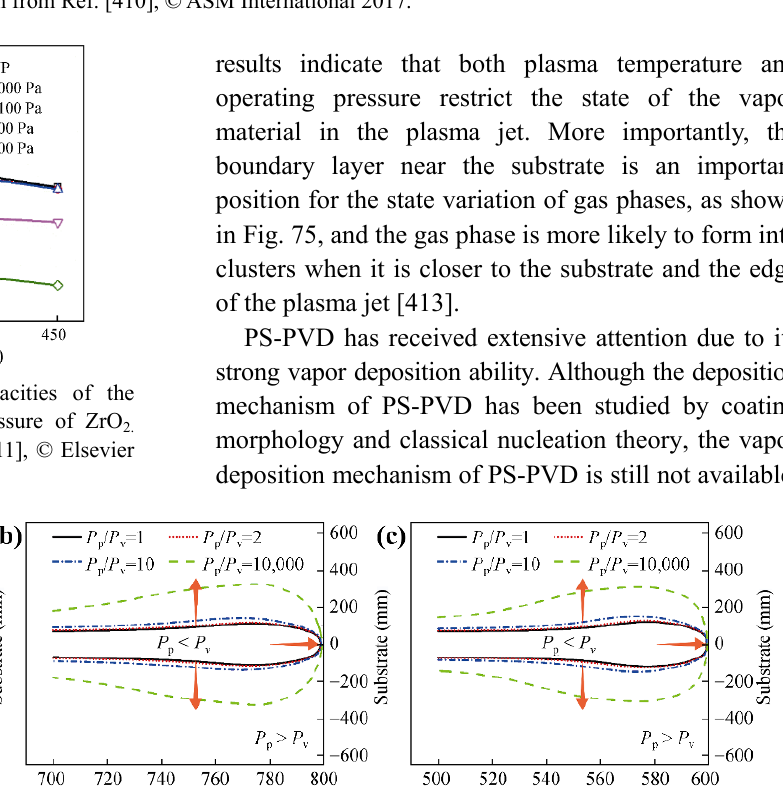
Fig. 73 Evaporation of molten ZrO 2 in plasma jet: (a) evaporation model of molten ZrO 2 in plasma jet. Here, Q evap is the heat taken away by evaporation; r is the initial size of the molten ZrO 2 ; T is the initial temperature of molten ZrO 2 ; m conv is the vaporized mass of molten ZrO 2 ; Q conv is the heat transfer by the plasma jet; and T ' is the temperature of residual molten ZrO 2 . Enthalpy transferred from plasma jet to molten ZrO 2 as a function of (b) diameter and (c) change in molten ZrO 2 size along spray distance. Reproduced with permission from Ref. [410], © ASM International 2017.